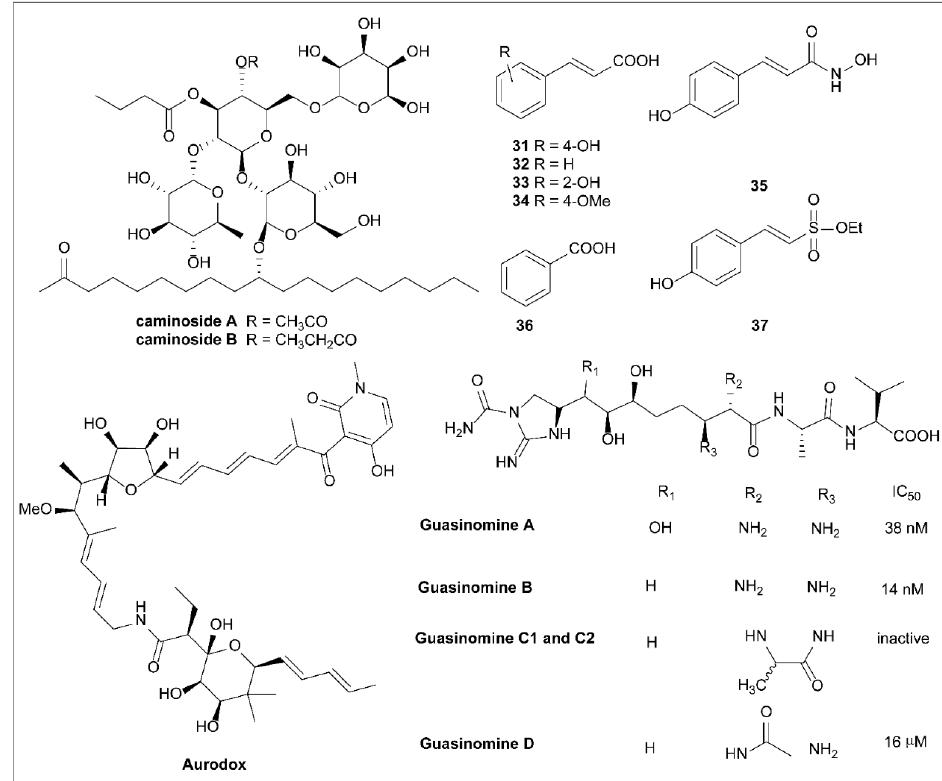
Figure 10. Structures of Caminoside A, Caminoside B, 31 – 37 , Aurodox, and Guasinomines.